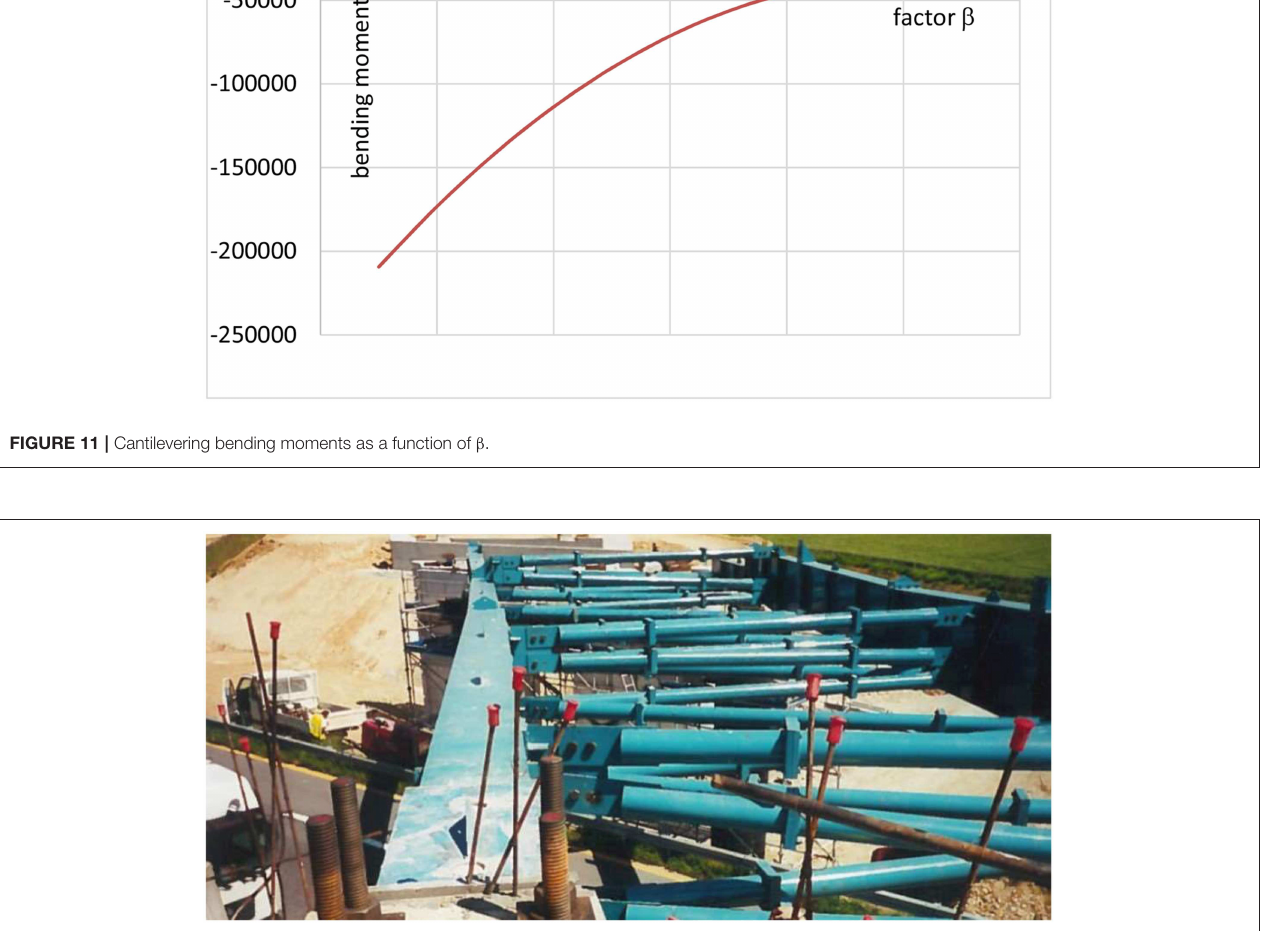
FIGURE 12 | Launching